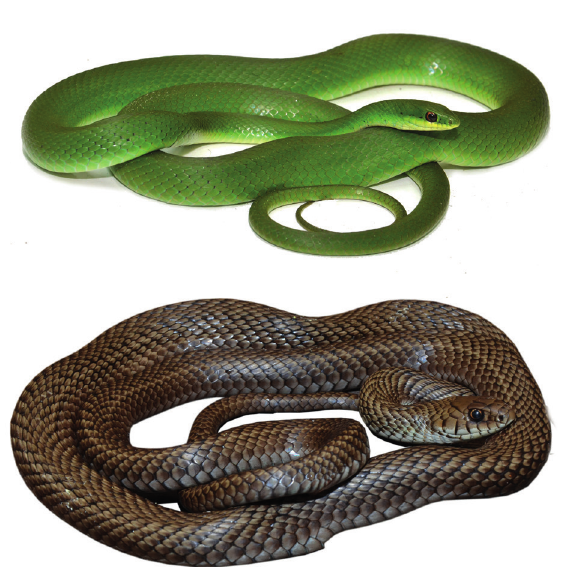
Figure 1 - Philodryas aestiva (upper image) and Philodryas patagoniensis (bottom image) from the Brazilian coastal Pampa, Rio grande do Sul state (photographed by Daniel